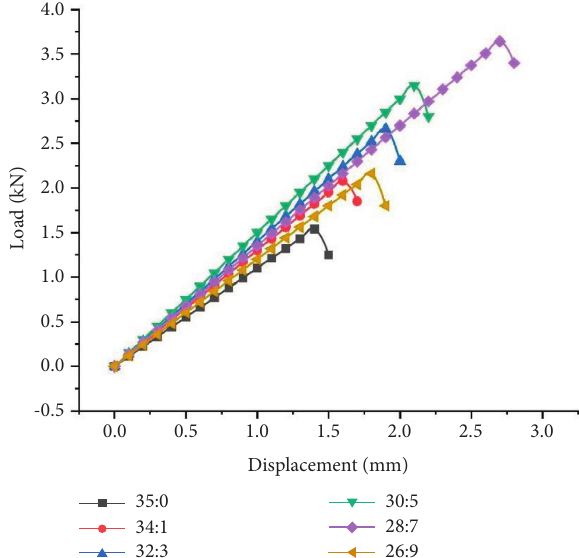
Figure 6: Displacement vs. load curves for epoxy resin/madar fibre/sugarcane bagasse ash composites.